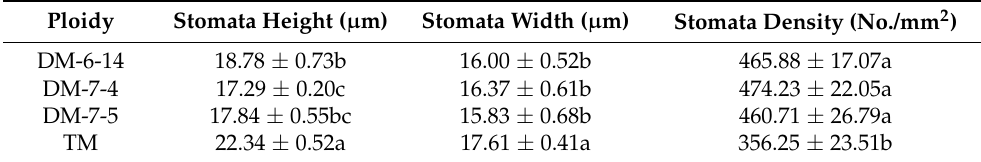
Table 8. Stomatal characters of diploid and triploid